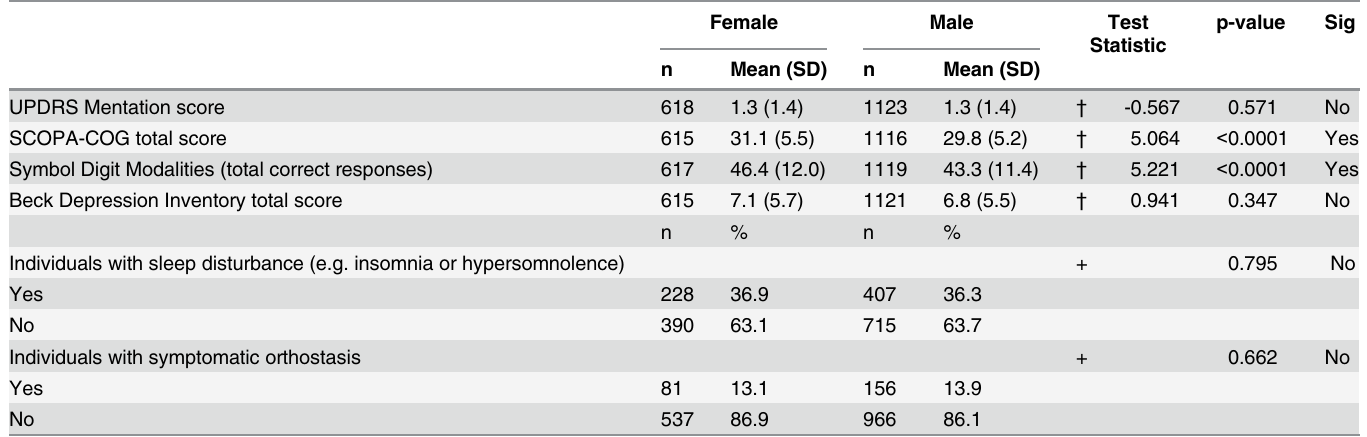
Table 3. Non-motor symptoms at the time of trial randomization ‡ .